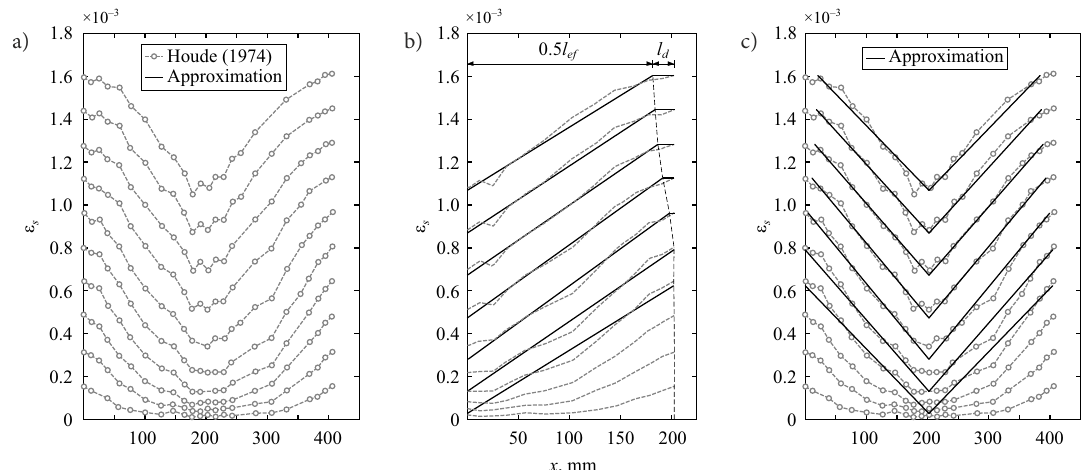
Figure 2. (a) Experimental strain profiles by Houde (1974); (b) Approximation of reinforcement strain profile with a linear shape function; (c) Linear approximation superimposed over the original data